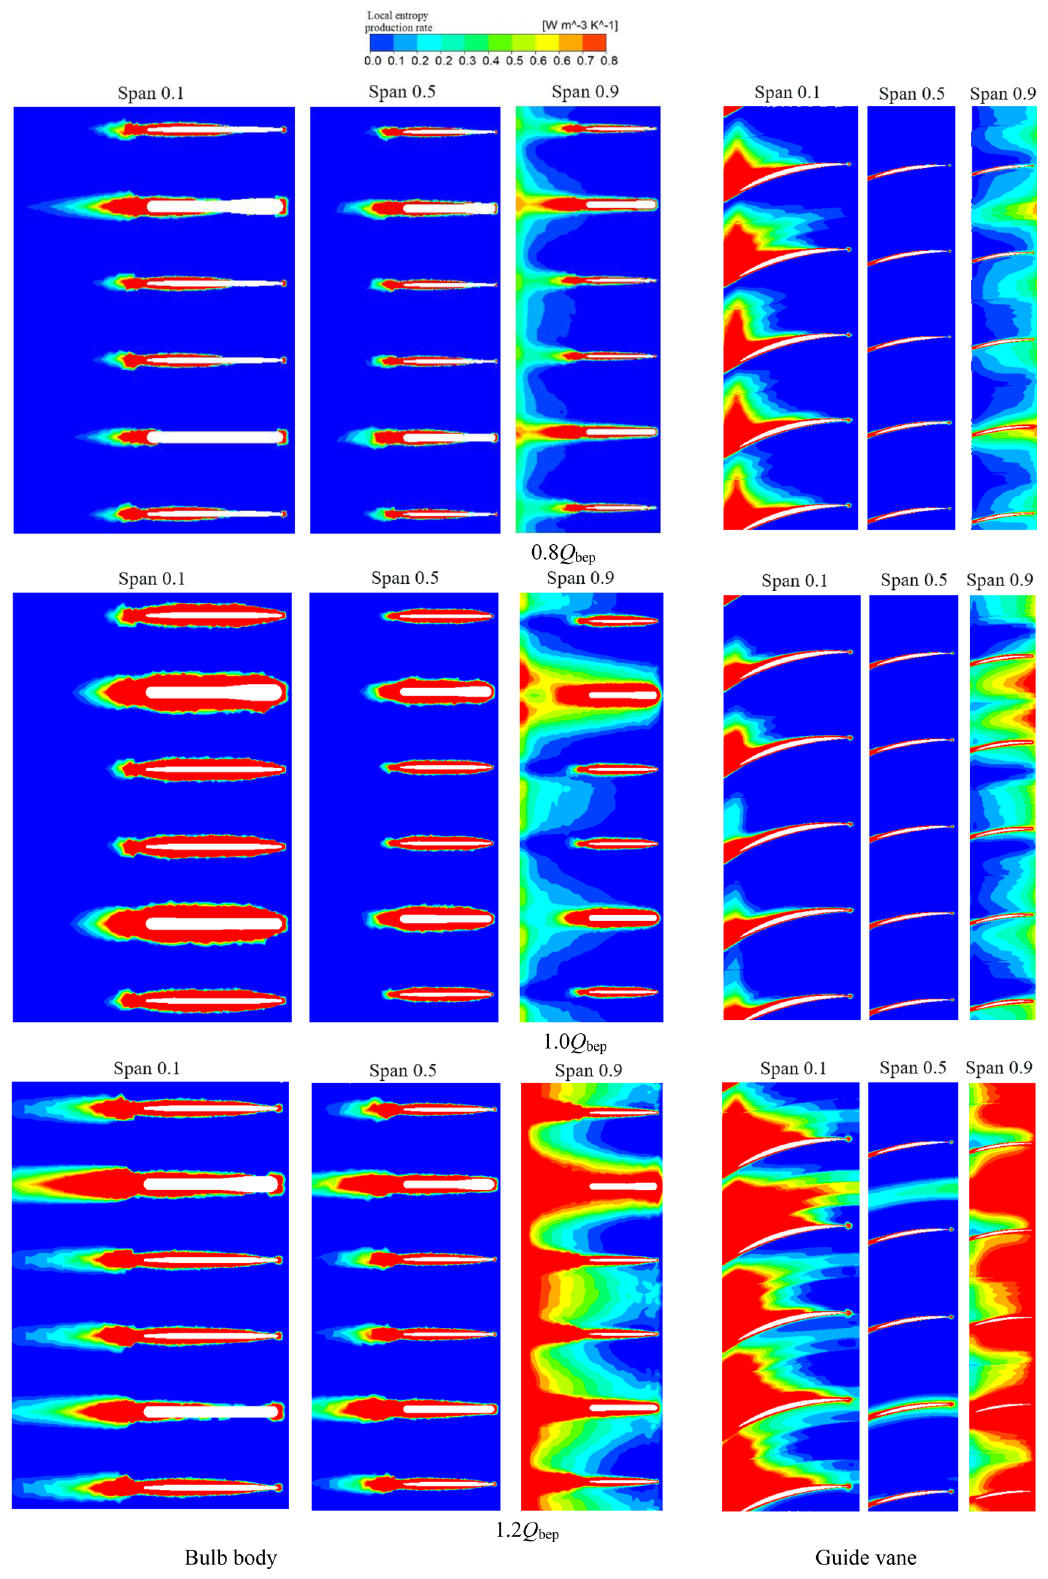
Figure 12. Local entropy production rate distribution of the leaf spreading section of the bulb body and guide